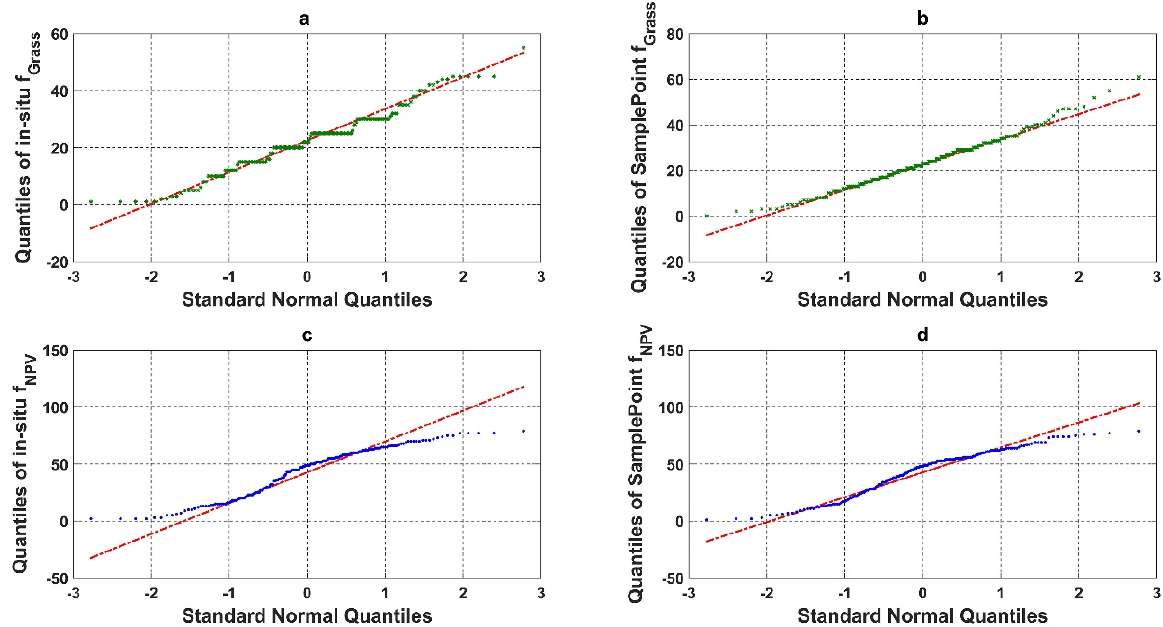
Figure 6. Quantile-quantile plot (qqplot) of ( a ) in situ assessment of Grass fractional cover (%), ( b ) SamplePoint classification of Grass fractional cover (%), ( c ) in situ assessment of NPV fractional cover (%), and ( d ) SamplePoint classification of NPV fractional cover (%).